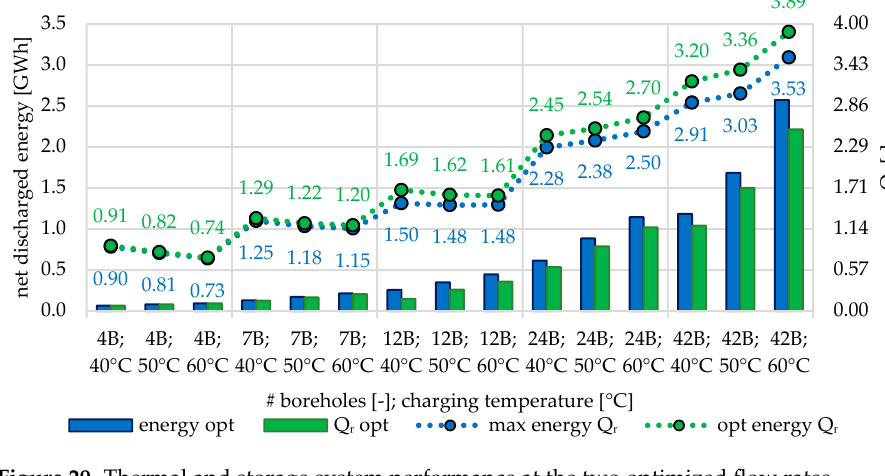
Figure 29. Thermal and storage system performance at the two optimized flow rates.